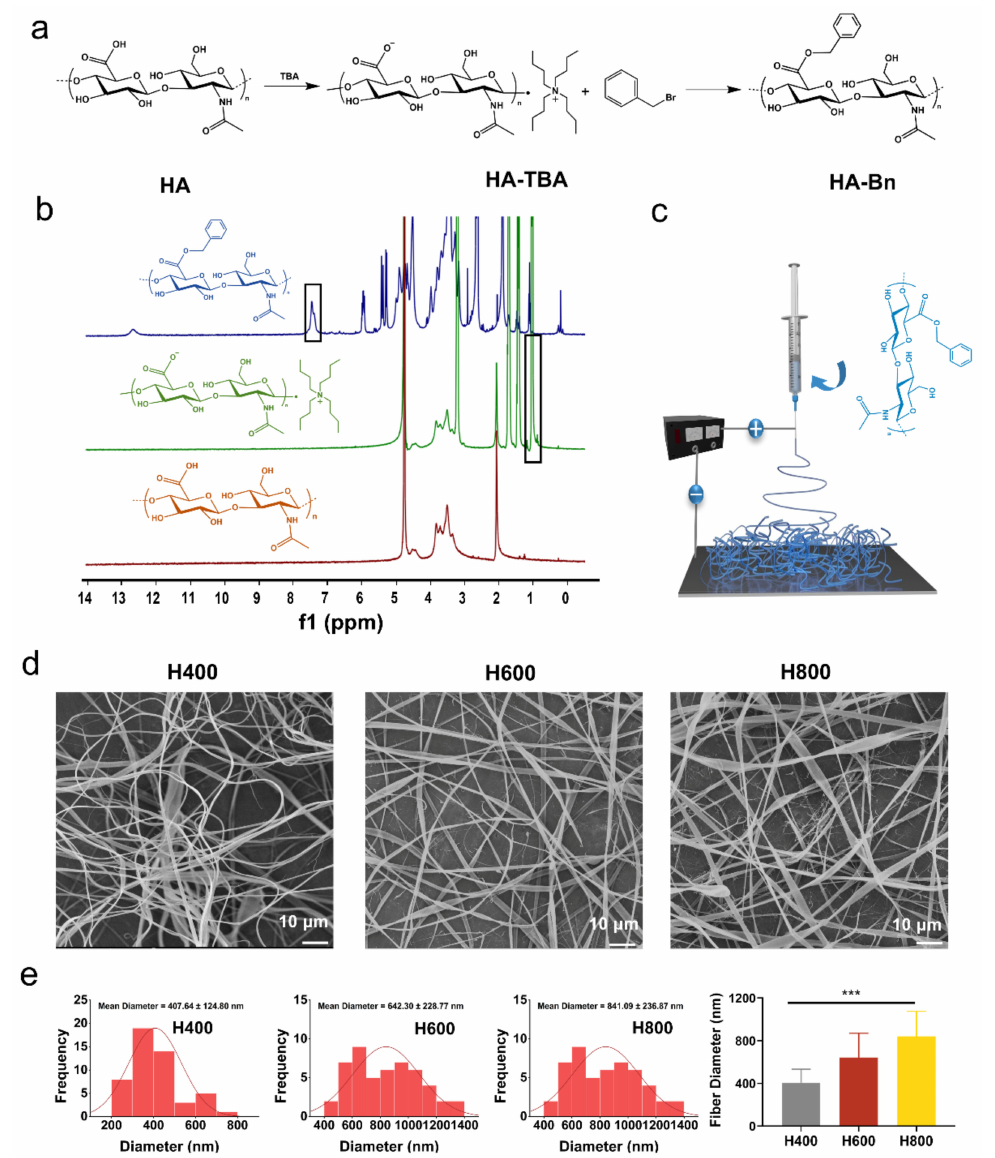
Figure 1. ( a ) Synthetic route of HA-Bn. ( b ) 1 H-NMR of products. ( c ) Schematic diagram of HA-Bn electro spinning. ( d ) SEM images and ( e ) corresponding diameter distributions of different diameter nanofibers. (*** indicates p <